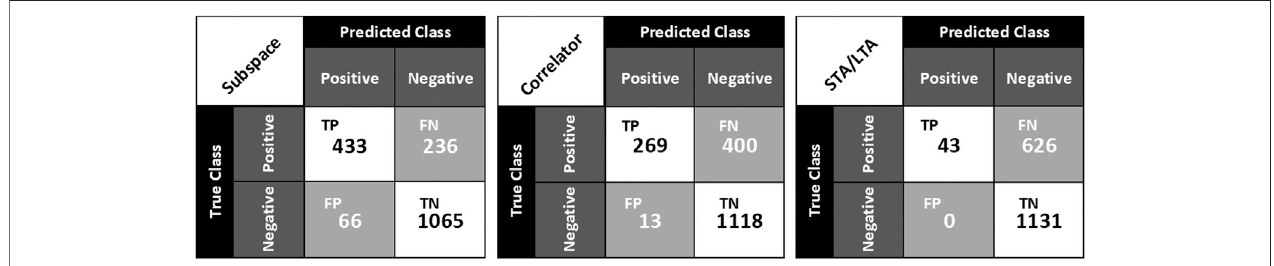
FIGURE 11 | Confusion matrices of subspace, correlator and STA/LTA triggering algorithms. True positive (TP), false positive (FP), true negative (TN) and false negative(FN)valueswereobtainedbyanaccurateanalysisconsistingofavisualinspectionofthe1 h-longbufferofcontinuousinfrasoundsignalanditscomparisonwith the detections.